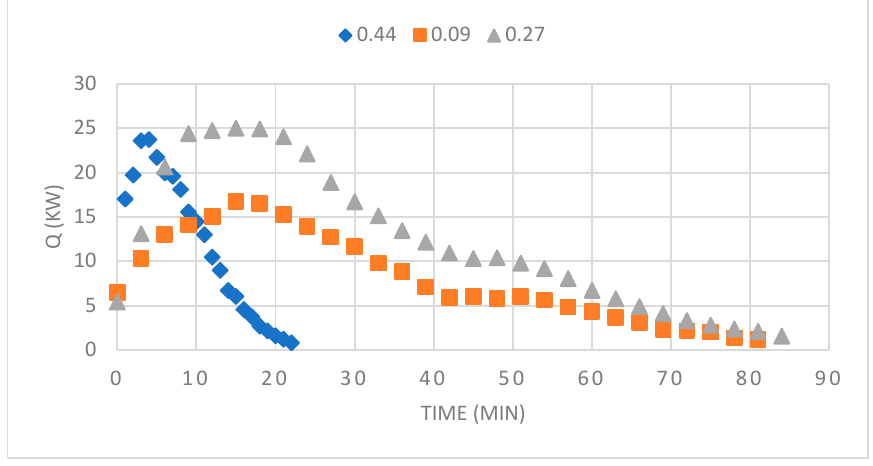
Figure 6. Evolution of the yielded power at different constant flow rates.